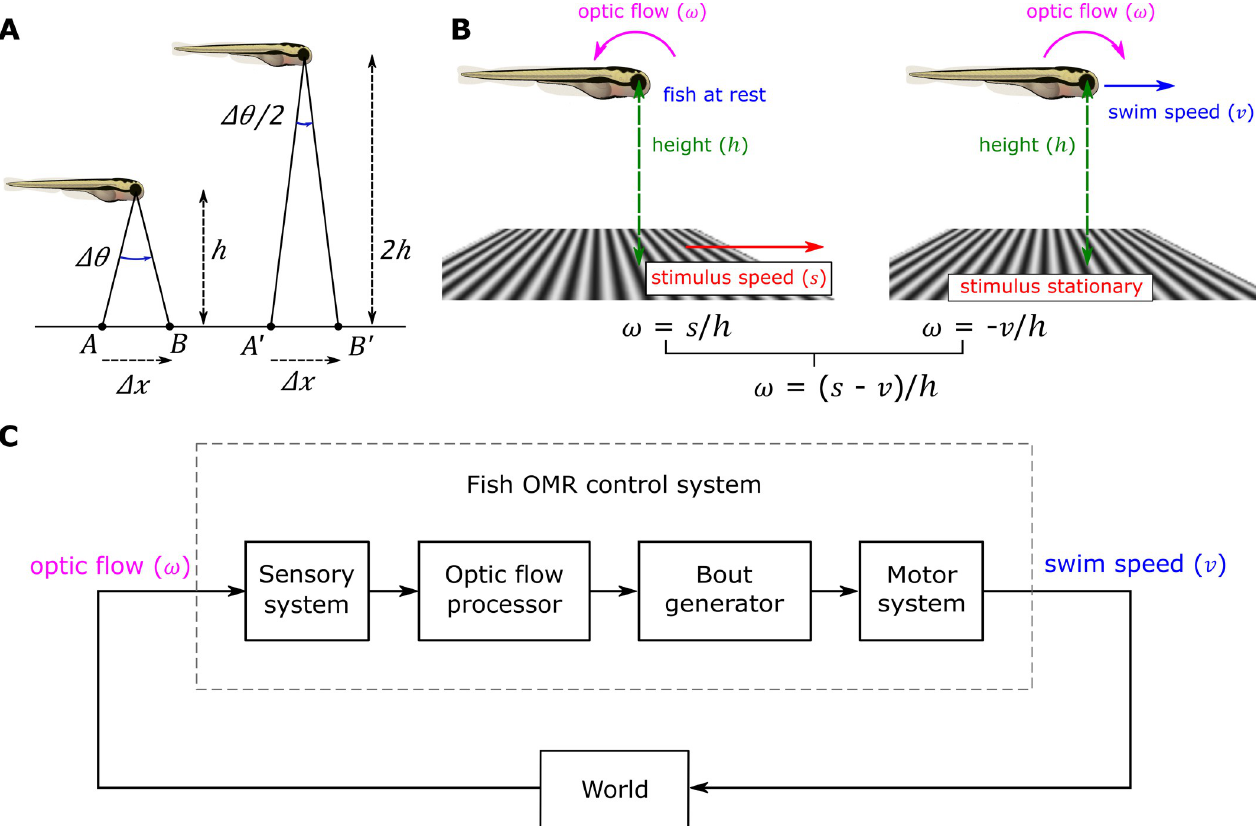
Fig 1. Optic flow and feedback control of the OMR. (A) Optic flow is inversely proportional to height. The fish on the left is at rest a distance above a moving stimulus. A point on the stimulus moves forward a small distance Δ x from A to B over time Δ t , causing the angle of the ray passing from that point through the optical center of the eye to change by Δ θ with corresponding optic flow of Δ θ / Δ t radians/s. The fish on the right at twice a height experiences half the change in angle, Δ θ / 2 , for the same small stimulus movement in the same time, and thus half the optic flow. If the stimulus speed is s , Δ θ = Δ θ / h = s Δ t / h , so the optical flow ω = Δ θ / Δ t = s / h . (B) Optic flow is a combination of baseline flow and swim-induced flow. As in (A), a fish at rest at height h with the stimulus below moving at speed s experiences a positive (anticlockwise) baseline optic flow of s / h rad/s when expressed as an angular velocity (left). Conversely, swimming at speed ν over a stationary grid induces a negative optic flow of - ν / h rad/s (right). When both fish and the grid are moving the opposing optic flows sum to a total of ( s - ν )/ h rad/s. (C). The overall system is a closed-loop feedback system with gain inversely proportional to height. Any change in the swim speed output causes a change in the optic flow input, which in turn feeds back to affect future swimming. Following [9], the system’s feedback gain can be defined as the change in optic flow caused by a small change in the swim speed taken as an index of motor effort, divided by that swim speed change, i.e., the derivative of the input with respect to the output dω / dν . The optic flow ω = ( s - ν )/ h , with s and h constant for any given trial, so the feedback gain dω / dν = -1/ h . Like the optic flow itself, the feedback gain is inversely proportional to the height of the fish above the ground–in fact it is just the negative reciprocal of the height.